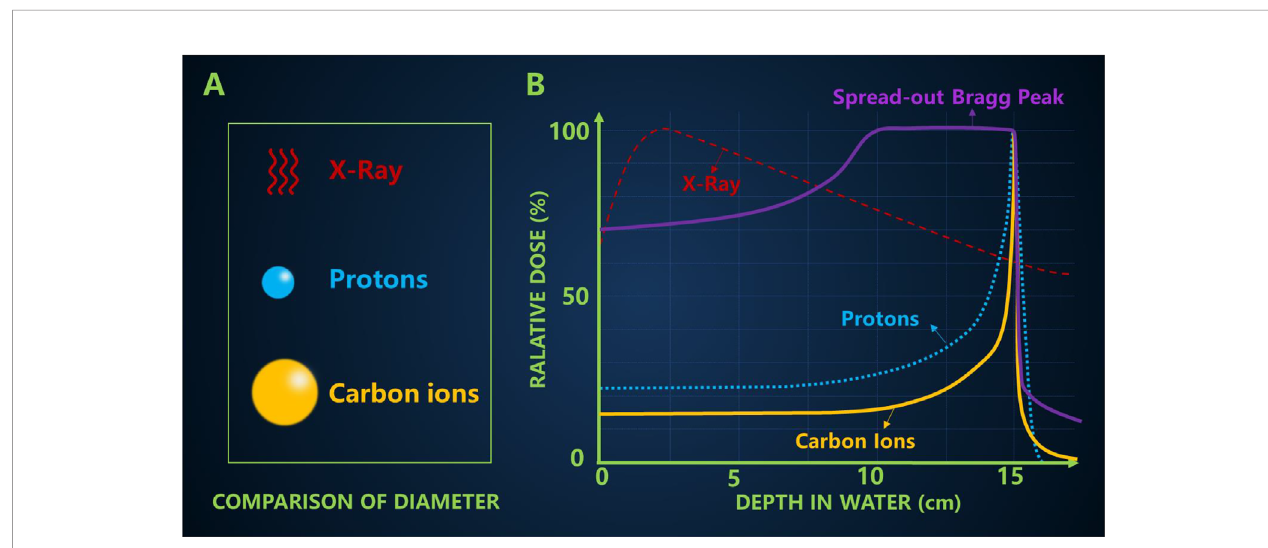
FIGURE 3 | (A) Comparison of particle size (B) The typical depth dose curves of X-ray, protons and carbon ion beams, and a spread-out Bragg peak (SOBP) created by super-positioning many Bragg peaks at different